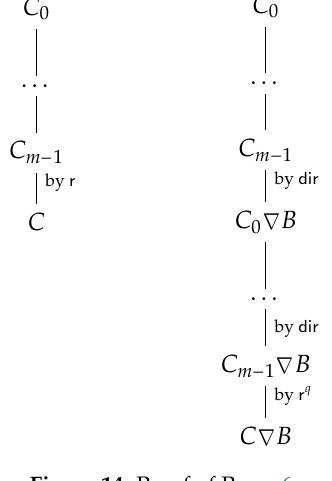
Figure 14. Proof of Prop.